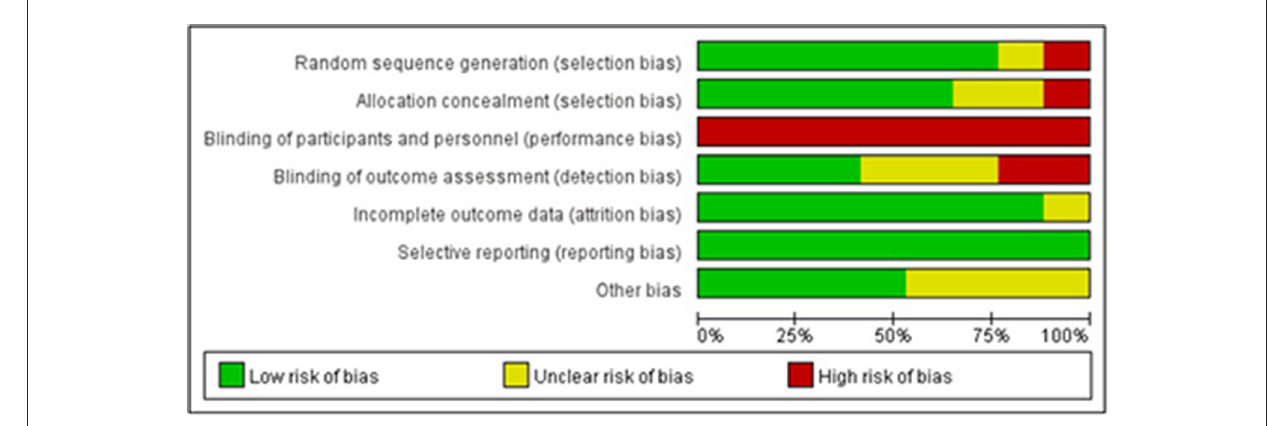
FIGURE4 Risk of bias summaries for all studies.